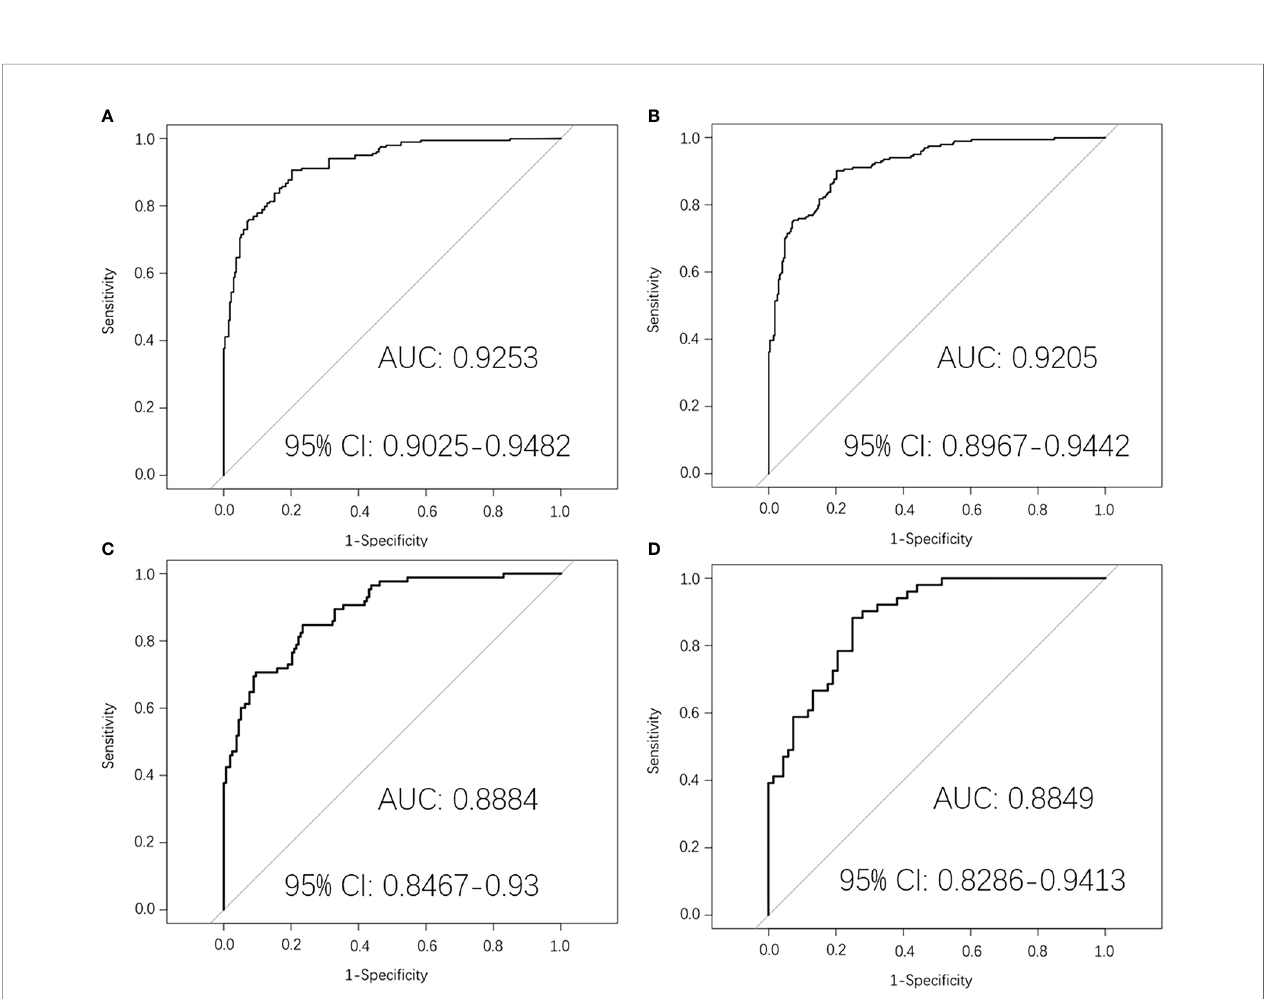
FIGURE 4 | Mid-treatment MRI-radiomics model in each dataset predicted the ROC curves of the PFS in LA-NPC. (A) shows the ROC curve of the MRI-radiomics model in the training dataset of mid-treatment, and (B) shows the average ROC curve of 10-fold cross-validation of the MRI-radiomics model in the training dataset. (C, D) represent the ROC curve of the MRI-radiomics model in the original dataset and test dataset, respectively.